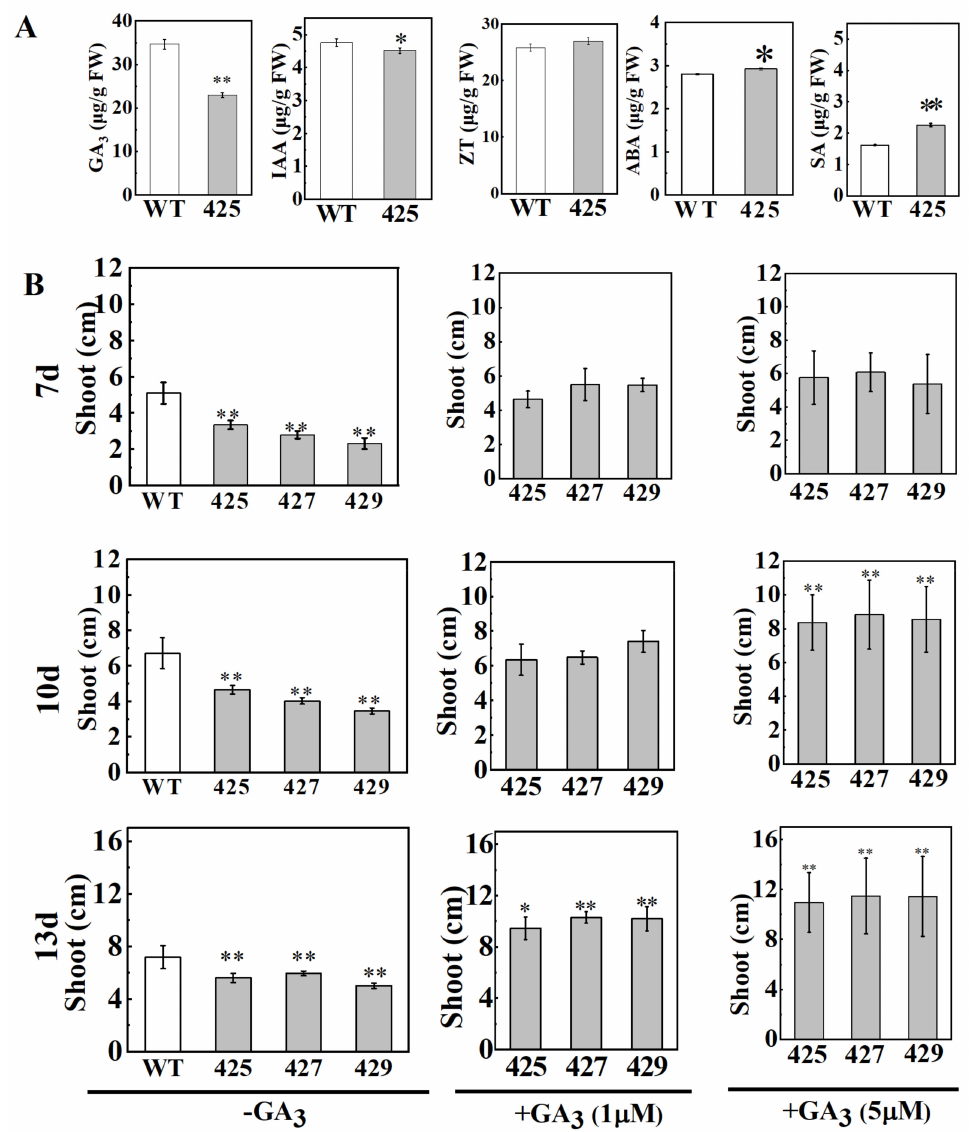
Figure 4. The hormones changes in OE plants and semi-dwarf phenotype could be Rescued by Exogenous GA 3 Treatment. ( A ) Contents of endogenous hormones GA 3, IAA, ZT, ABA, and SA in the stems from the wild-type ZH11 and OE line plants (* p < 0.05, ** p < 0.01, t -test, n = 15). ( B ) wild-type ZH11 and three OE lines (425, 427, and 429) treated without or with 1 µ mol/L GA 3 and 5 µ mol/L at seedling stage (Values are means ± SD, * p < 0.05, ** p < 0.01, t -test, n = 15). 2.5. Overexpression of OsWRKY21 Altered the Expression Levels of the Genes for Phytohormones Metabolic Pathway and Secondary Cell Wall